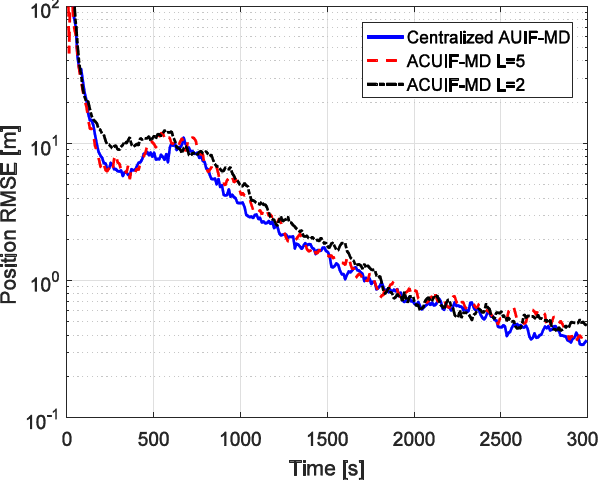
Figure 4. The position RMSE for different methods over time in case 1. Figure 5. The position RMSE for di ff erent methods over time in case